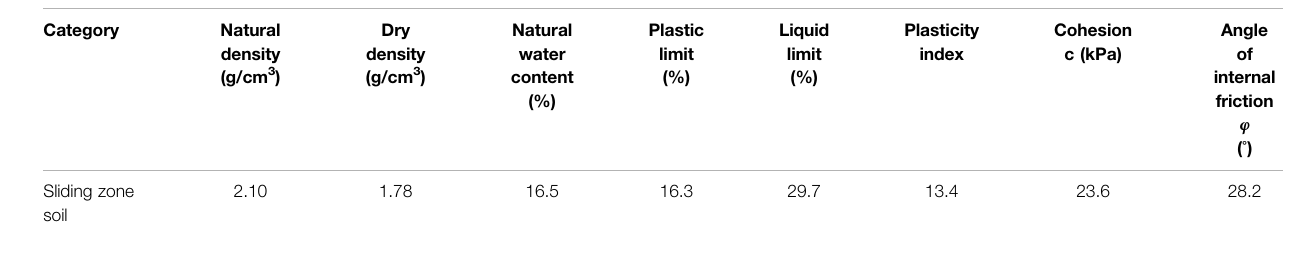
TABLE 1 | Test results of liquid – plastic limit combined determination.